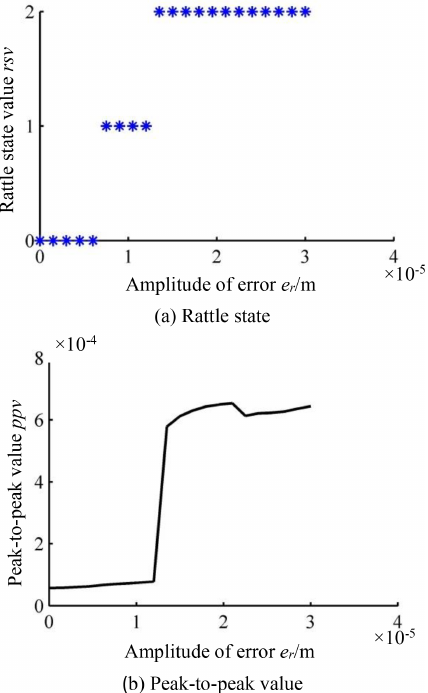
Figure 12. Change in vibration with the amplitude of the static transmission error.